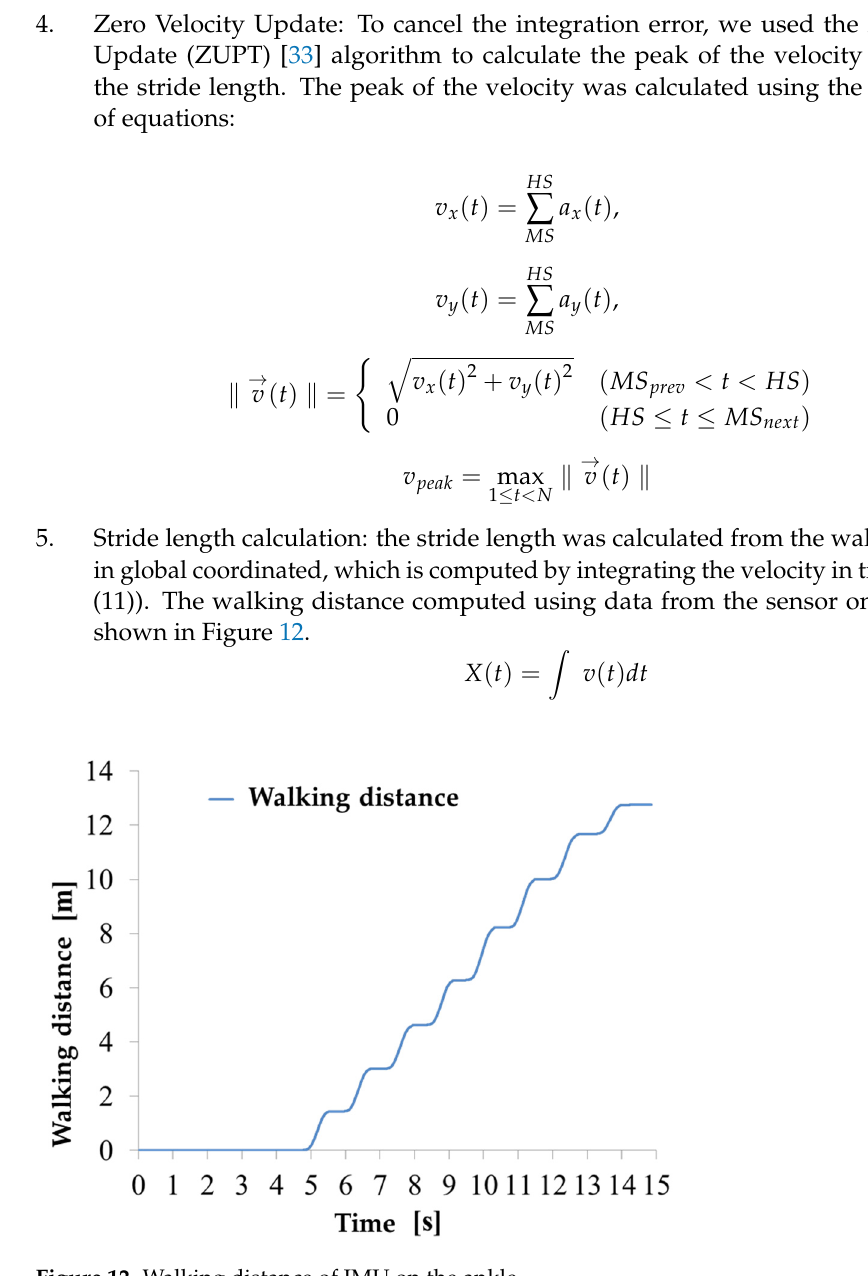
improve the algorithm accuracy against missteps, strides with a stride length of 30 cm or less are ignored [34]. 𝑙 (cid:3046)(cid:3047)(cid:3045)(cid:3036)(cid:3031)(cid:3032) (𝑖) (cid:3404) (cid:4682)